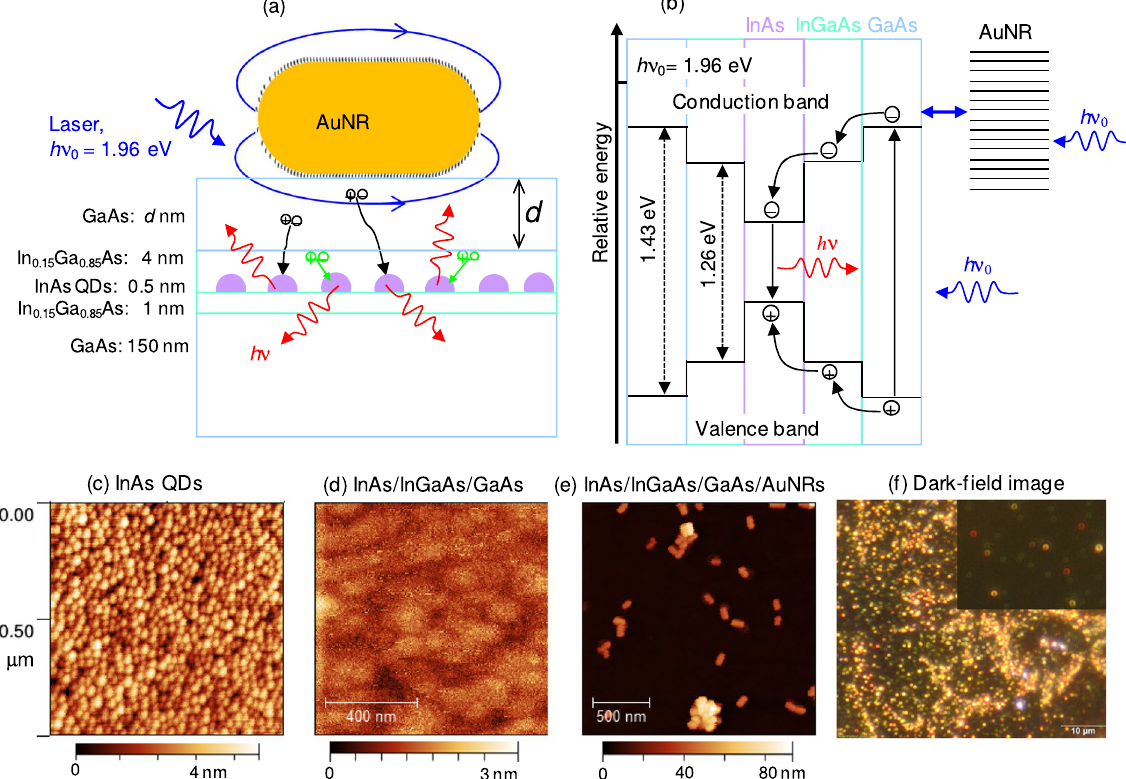
Figure 1. Integration of semiconductor and plasmonic materials for the studies of plasmon enhanced exciton generation and photon emission. ( a ) Schematic showing the InAs quantum dots (QDs) confined in an InGaAs quantum well, capped with GaAs of variable thickness ( d ) and coupled to a single gold nanorod (AuNR). The short lines around the colloidal AuNR represent the surface ligands (cetyltrimethylammonium bromide). The plasmon near-field enhances electron-hole pair generation in the GaAs and InGaAs layers and the enhancement of photon emission by the InAs QDs depends on the carrier capture rates from the GaAs (black arrow) and from the InGaAs well (green arrow) by the QDs. ( b ) The energy level diagram shows that the excitation energy (1.96 eV) is high enough to promote electron from the valence band to the conduction band in any of the materials including the GaAs that has the highest band gap energy. ( c – e ) Topographic AFM scan images obtained before the InGaAs and GaAs layers are grown ( d ), after the InGaAs and GaAs layers are grown ( e ), and after the AuNRs are drop-casted on the GaAs surface. ( f ) Dark-field image of AuNRs on GaAs surface. The color of the dark-field images of the individual AuNRs varies from red to green, depending on the proximity of the AuNRs to the GaAs